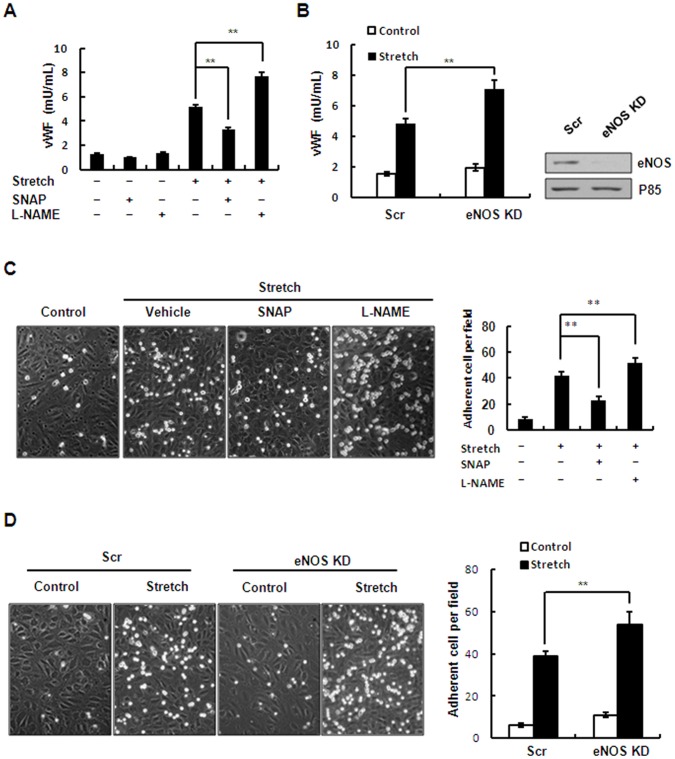
Effect of stretch-induced eNOS activation and NO production on WPB exocytosis and leukocyte adhesion.(A) Quantitative analysis of stretch-induced vWF release from HUVECs pretreated with SNAP (50 µM), L-NAME (1 mM) or vehicle (DMSO). (B) Left: quantitative analysis of stretch-induced vWF release from HUVECs expressing scrambled (Scr) or eNOS-targeting (eNOS KD) shRNAs. Right: Western blots of the knockdown efficiency of shRNAs targeting eNOS in HUVECs. (C) Left: HL-60 cell adhesion to HUVEC monolayers after stretch, pretreated with SNAP (50 µM), L-NANE (1 mM) or vehicle (DMSO). Right: quantitative analysis of HL-60 adhesion. (D) Left: stretch-induced HL-60 cell adhesion to HUVECs expressing scrambled (Scr) or eNOS-targeting (eNOS KD) shRNAs. Right: quantitative analysis of HL-60 adhesion. Results are representative of 3 individual experiments and expressed as mean ± S.D. (n = 4). **P<0.01.